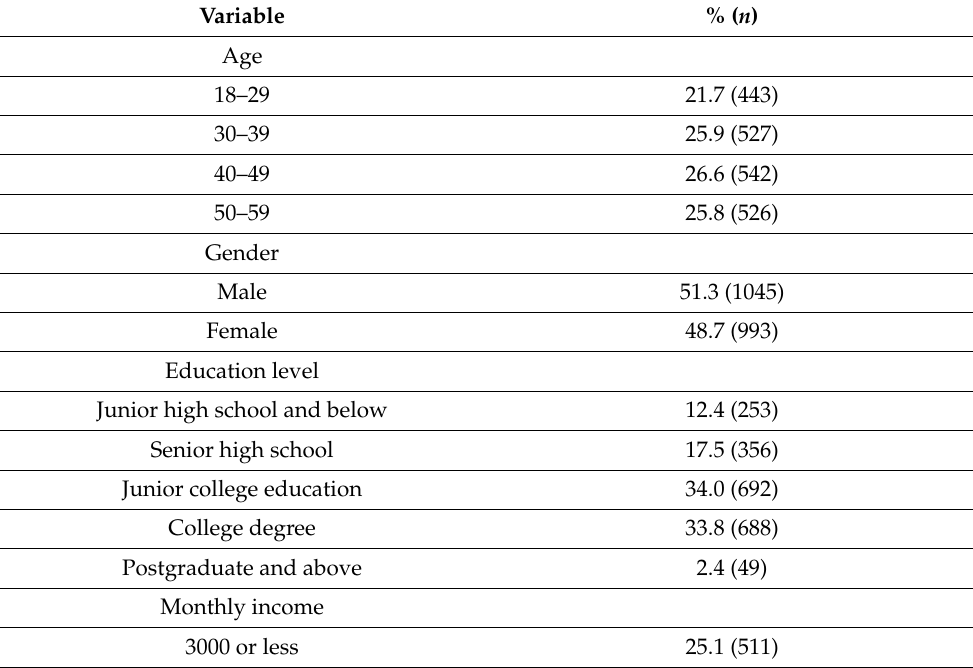
Table 1. Distribution of demographic characteristics of the sample ( n =